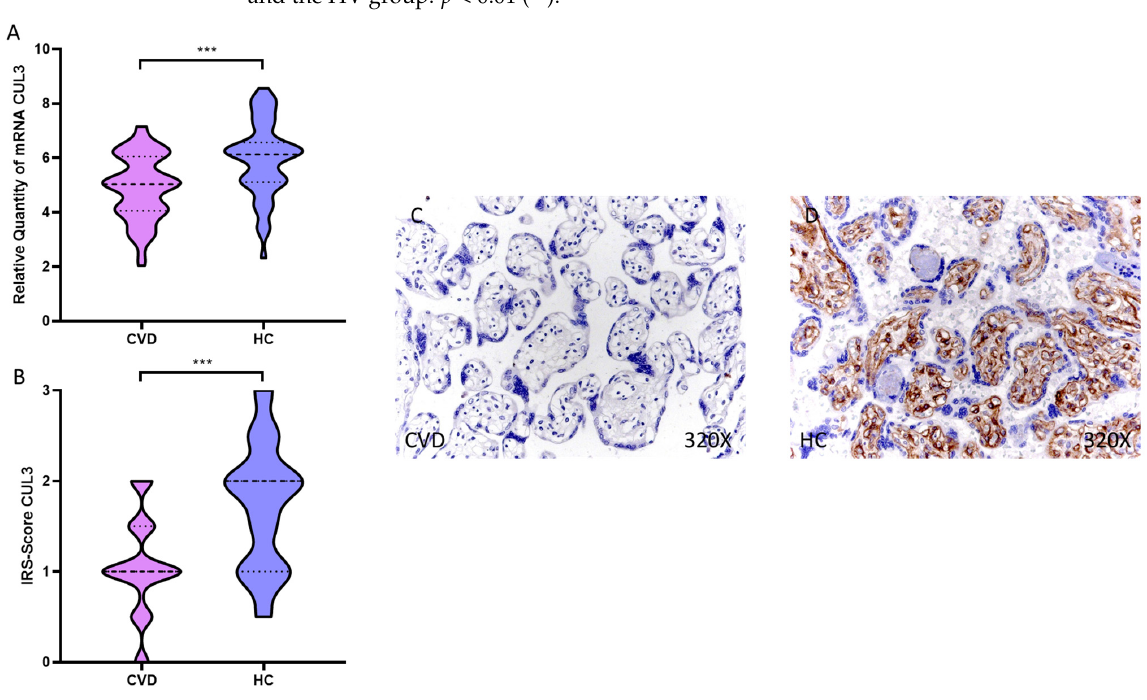
Figure 3. ( A ). CUL3 mRNA expression in the CVD patients (chronic venous disease) and HC group (Healthy controls). ( B ). IRS-Scores for CUL3 in the placenta villi of the CVD group and the HV group. ( C , D ). Images showing the immunostaining for CUL3 in the placenta villi of the CVD group and the HV group. p < 0.001 (***).